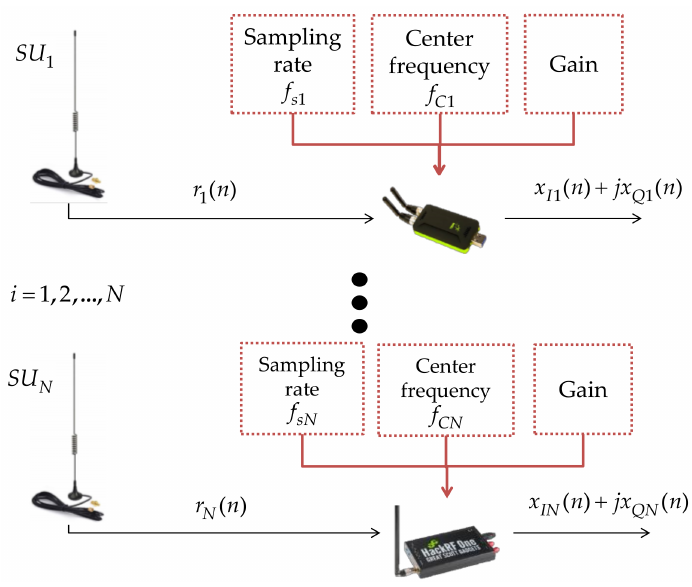
Figure 2. Sensing stage: received signals for the SDR devices, updated every 100